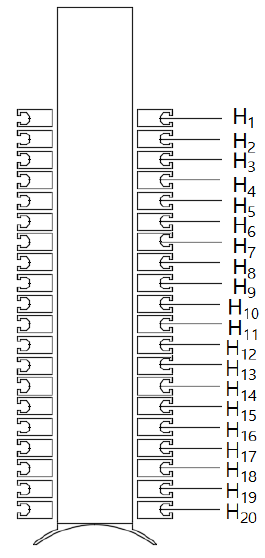
Figure 3. Initial for installation of CdS photoresistors height.